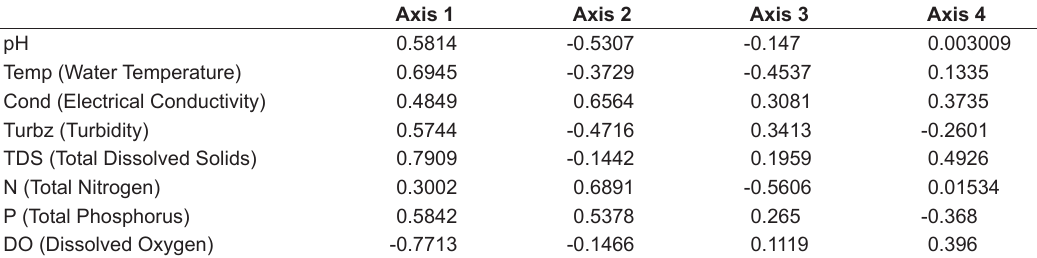
Table 2. Correlation of abiotic variables with the axes (components) of principal component analysis (PCA) for the variables analyzed for the sampling sites at Billings Reservoir (Brazil, São Paulo State).